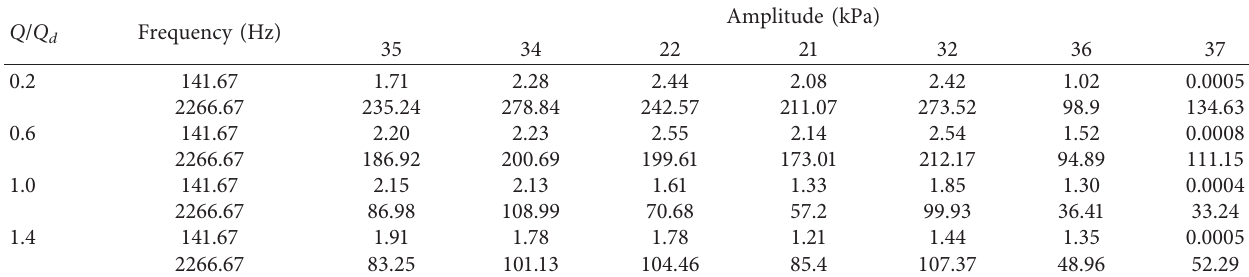
Figure 12: Pressure spectra of the diffuser for monitoring points: (a) 1, (b) 2, (c) 5, and (d) 6. Table 3: Amplitude of the main frequency at the impeller